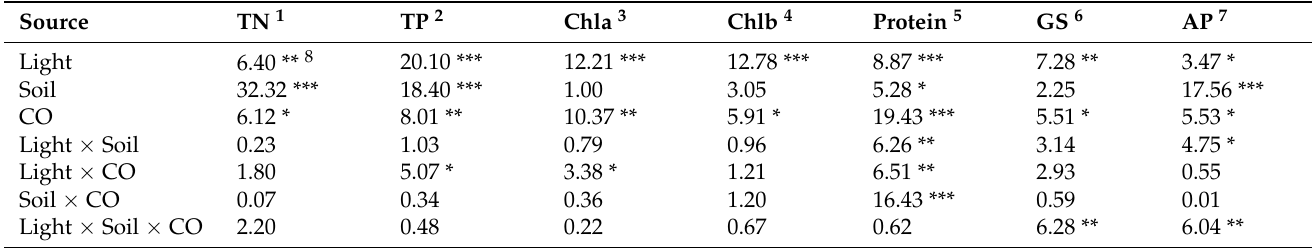
1 TN, total nitrogen (N) concentration; 2 TP, total phosphorus (P) concentration; 3 Chla, chlorophyl a content; 4 Chlb, chlorophyl b content; 5 Protein, leaf protein content; 6 GS, glutamine synthetase activity; 7 AP, acid phosphatase activity; 8 number of asterisks indicates degree of significance: *, p < 0.05; **, p < 0.01; ***, p <